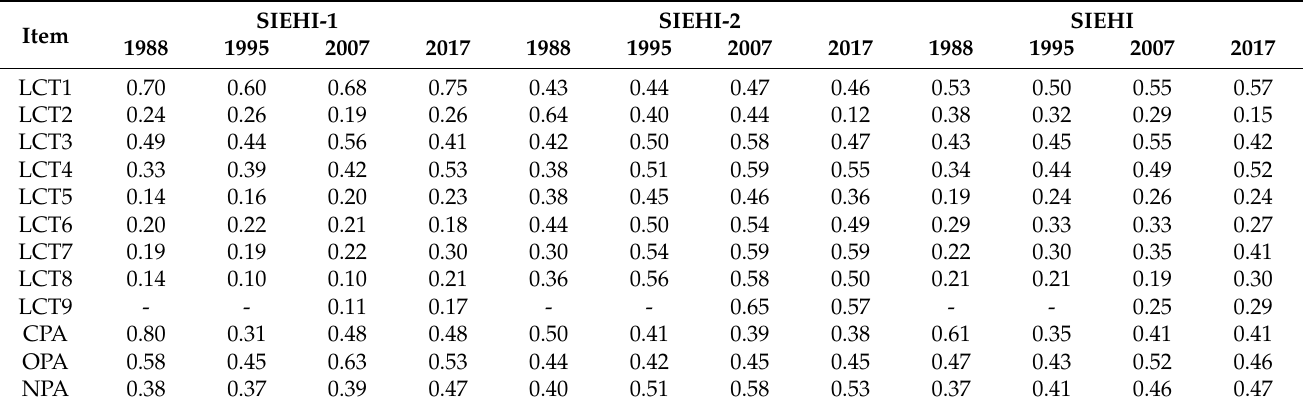
Table 3. Results of SIEHI-1, SIEHI-2, and SIEHI in different land cover types and protected